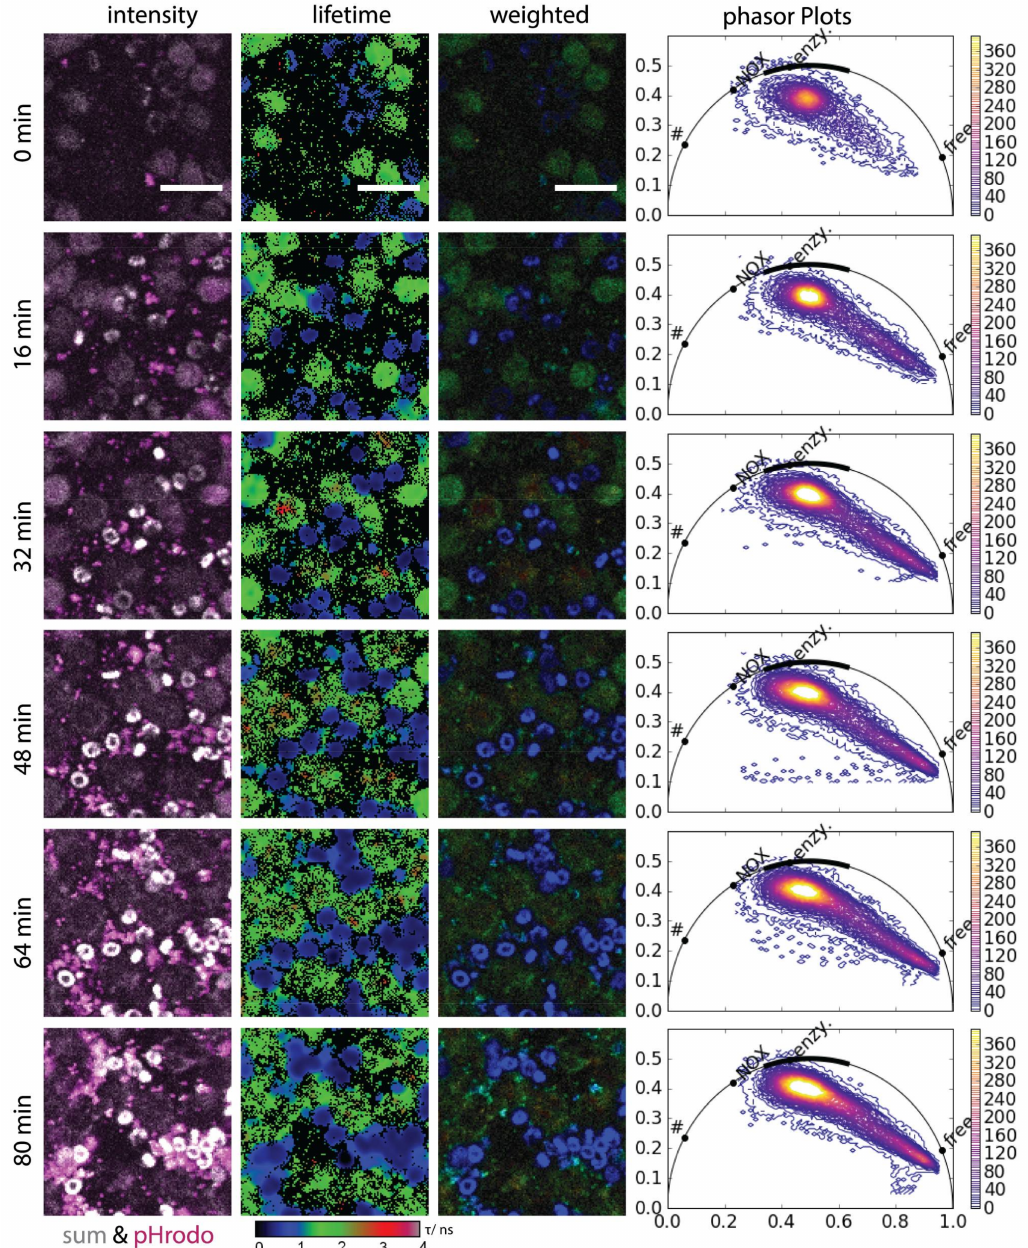
Figure 3. NAD(P)H-metabolism during phagocytosis. Selected frames of time-lapse NAD(P)H-FLIM data of healthy human neutrophil granulocytes phagocytosing Staphylococcus aureus pHrodo™ beads (representative for n = 150 cells per individual, two healthy individuals). The first row shows the merged images of NAD(P)H fluorescence (grey) and acidic pHrodo™ beads (magenta). The second and third rows show corresponding original and intensity-weighted fluorescence lifetime images. During the imaging time, the beads are taken up by the neutrophils and became fluorescent due to the pH shift within the phagosomes. Both the color map of FLIM images and the phasor plots show over time a shift to activated NADPH oxidase 2 followed by a shift towards free NAD(P)H, which indicates cellular death. For a better visibility, only a 124 × 124 pixel area is shown from the original data (Movie 1). The phasor plots rely on the total area of 512 × 512 pixels, the movie is shown in original dimensions. In the movie, the ROI showed in the figure is marked. Scale bar = 20 µ m. In the phasor plots in b and c “free” encodes free NAD(P)H, “enzym.” NAD(P)H bound to metabolic enzymes, “NOX” NADPH bound to NADPH oxidases and “#” oxidized lipids as defined by Datta et